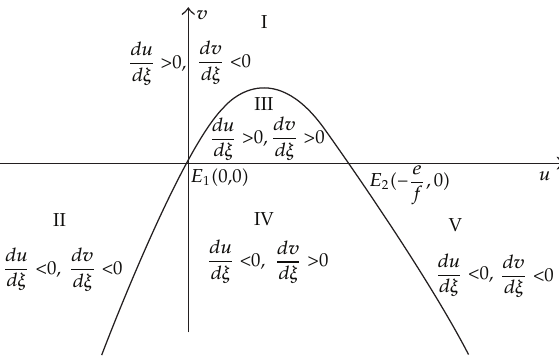
Figure 3: Signs of du/dξ and dv/dξ in di ff erent regions.